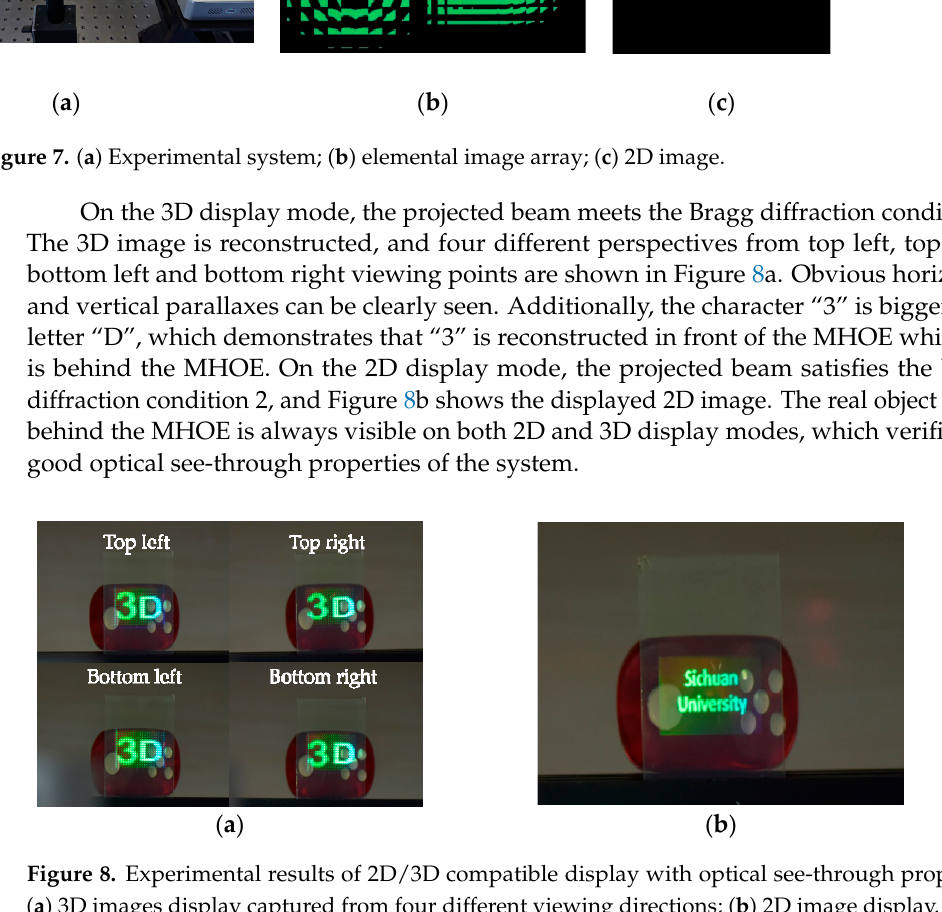
Figure 8. Experimental results of 2D/3D compatible display with optical see-through properties: ( a ) 3D images display captured from four different viewing directions; ( b ) 2D image display.